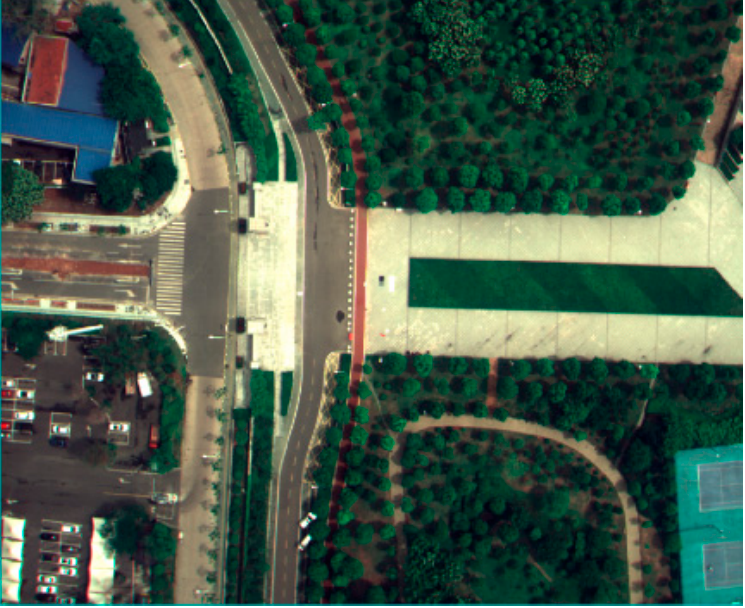
Figure 1. Study area in Wuhan city, China.